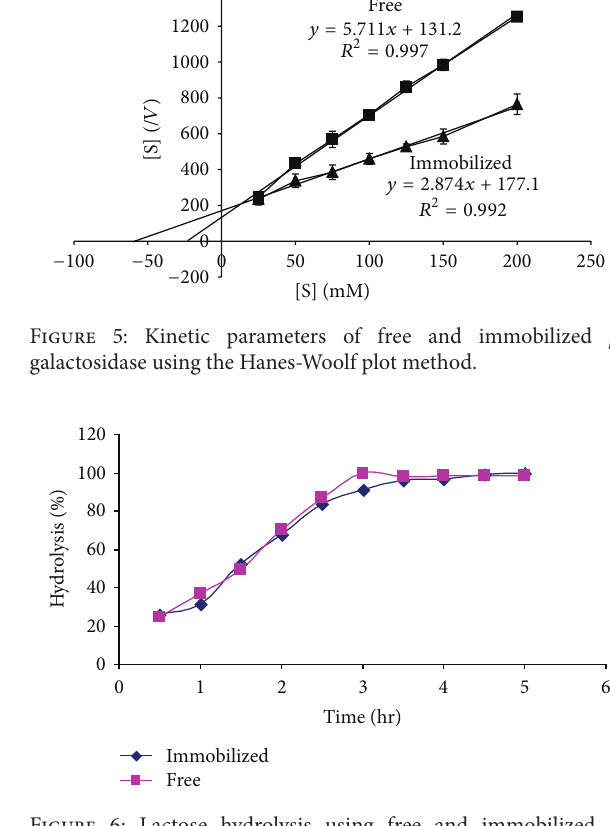
Figure 6: Lactose hydrolysis using free and immobilized 𝛽 - galactosidase onto PEI treated gel